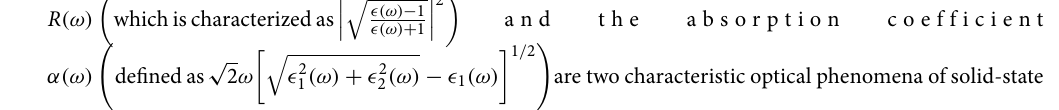
) = 0.77/0.77/0.83 for x-/y-/z-directions), which may have good optical ∞